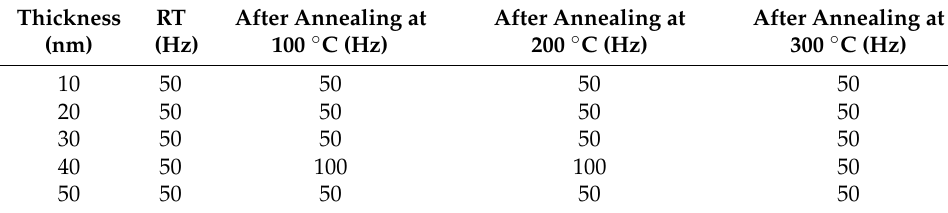
Table 2. Optimal resonance frequency for films of various